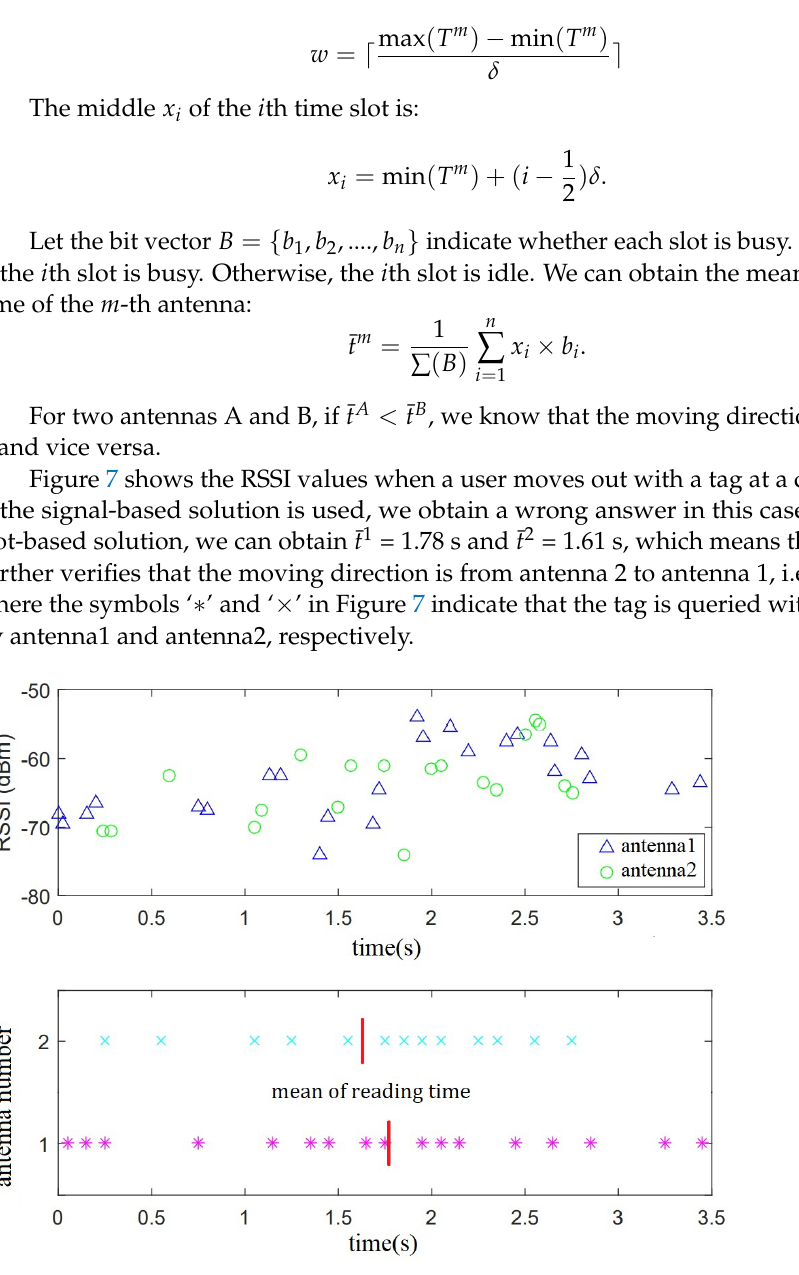
Figure 7. An illustration of time-slot-based